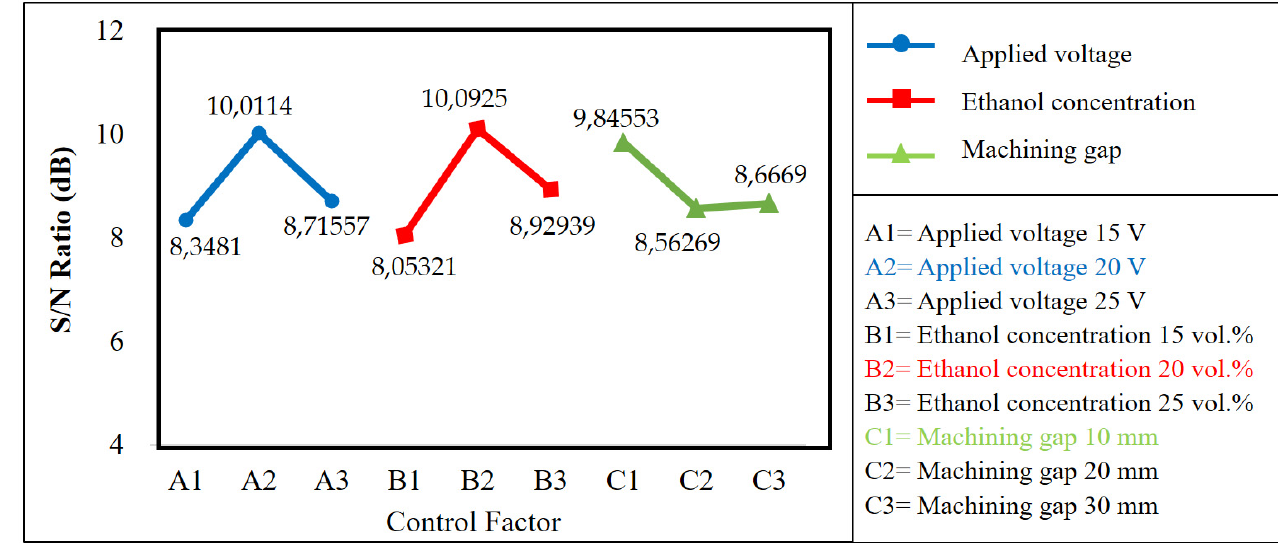
Figure 4. The optimal levels based on the results of surface roughness produced by EP.